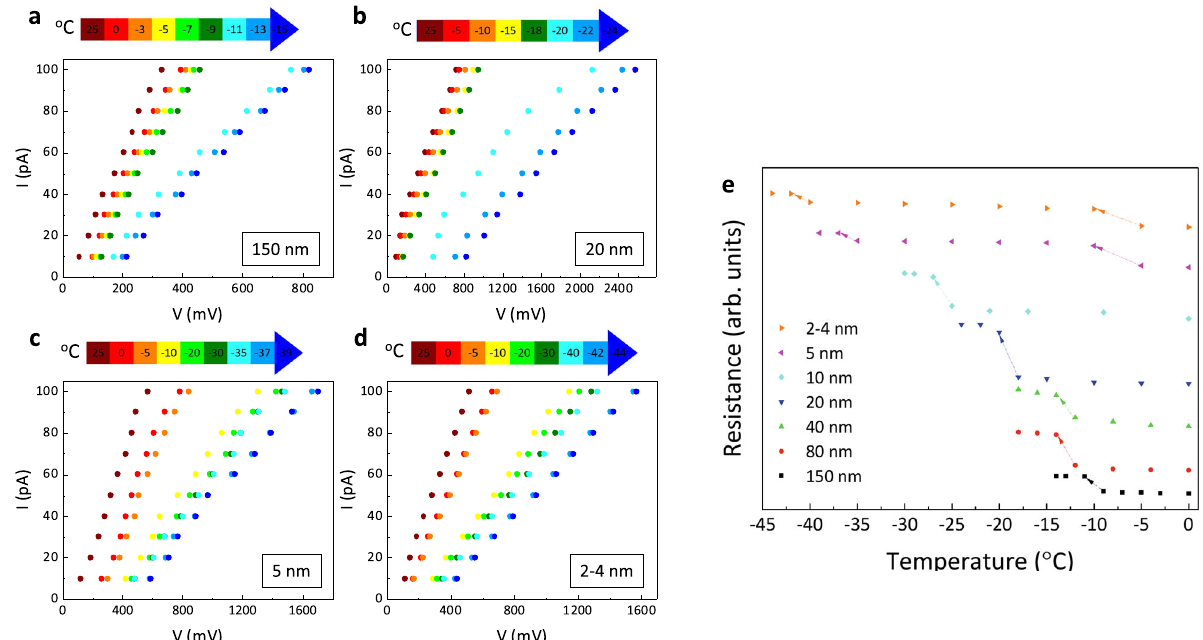
Fig. 2 Electrical resistance metrology. I – V curves were measured at different temperatures across the nanopores con fi ning nanodroplets. a Nanodroplets of ~150 nm, in which a nonlinear jump in electrical resistance is measured between the temperature of − 9 and − 11 °C. The resistance jump indicates water – ice phase change and suggests nucleation temperature ( T N ) at this length-scale. b For nanodroplets of ~20 nm, the resistance jump and consequently phase change is detected between − 18 and − 20 °C. c The T N value drops to ~ − 36 °C for 5 nm nanodroplets. Note that there are two resistance jumps for these pores as there are two dimensions of pore in these membranes, large pores of (150 – 200 nm) and small pores of 5 nm. d The T N value drops to − 41 °C below the limit of homogeneous bulk nucleation for 2 nm water droplets. e The normalized resistance jumps for different dimensions of water nanodroplets are shown. The electrical resistance metrology for other pore dimensions is provided in the Supplementary